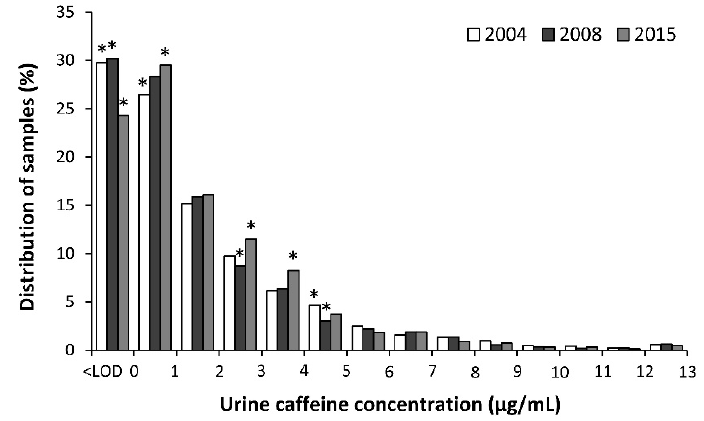
Figure 2. Distribution of urine samples according to the concentration of caffeine in 2004, 2008, and 2015. (*) Different from the expected value. LOD: limit of detection.